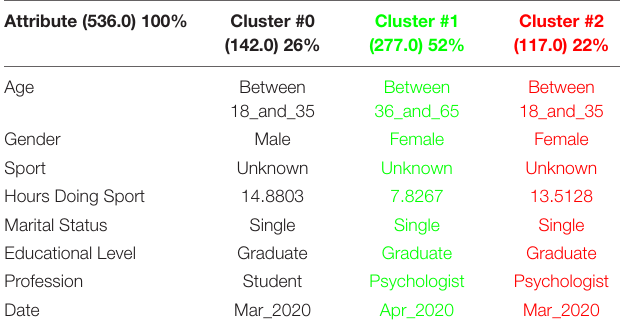
TABLE 2 | 3 clusters CSAI-2 analysis for March to May 2020. Attribute (536.0) 100%